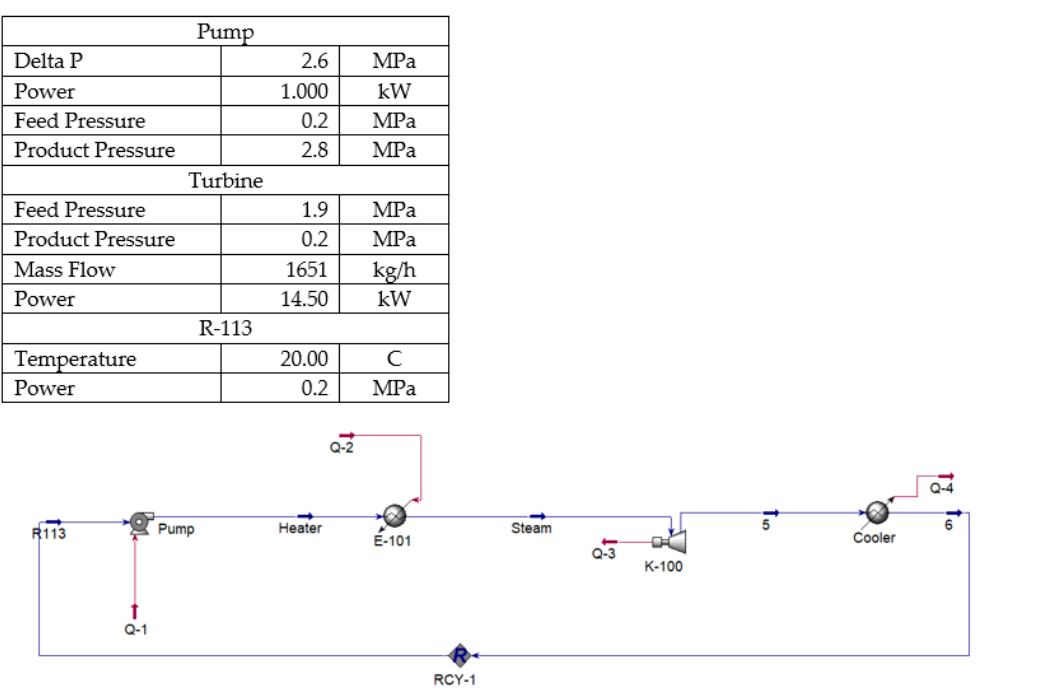
Figure 6. Simulation model for the second part of a binary system with a steam turbine.